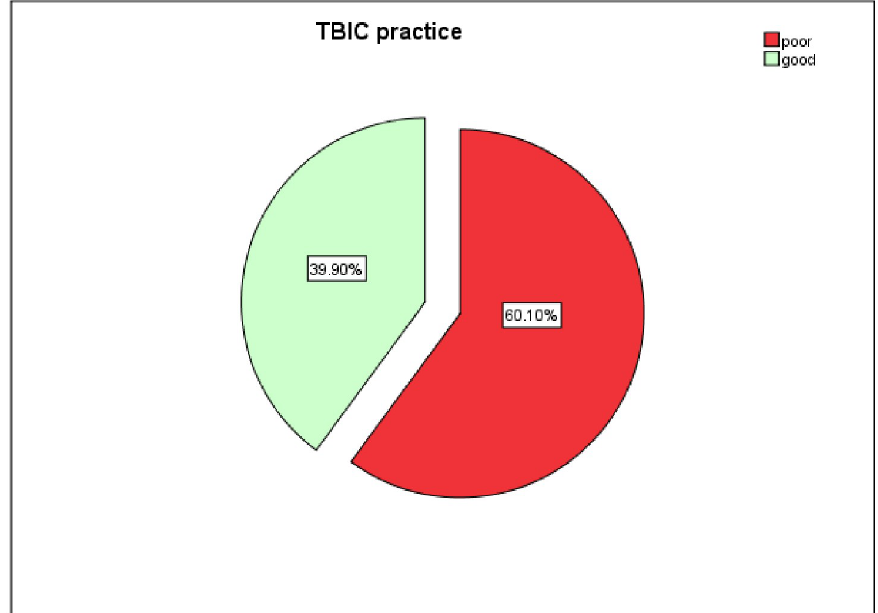
Fig 1. Tuberculosis infection control practice of healthcare workers, in Gamo Gofa Zone, Southern Ethiopia,